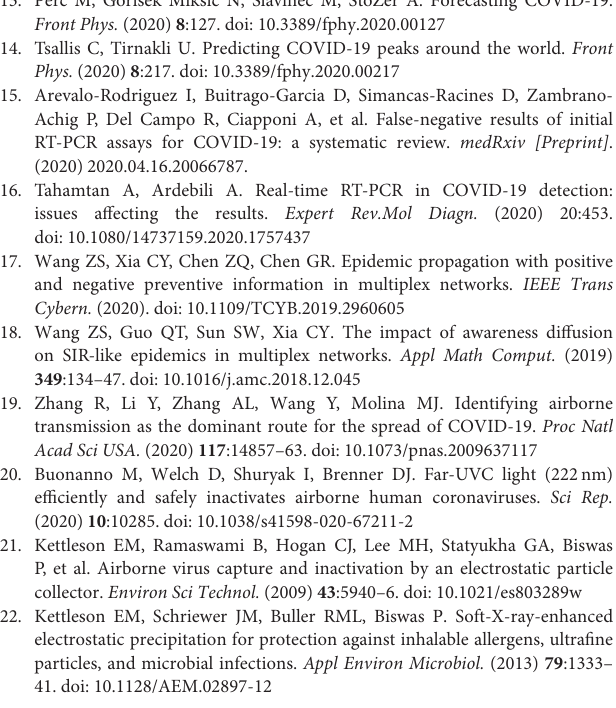
Figure 3E . The last five trials reproduce a scene as illustrated in Figure 3F . Green symbols indicate the moment of occurrence of new infections and orange circles represent the infected workers. The blue rectangles represent the infected workers in quarantine. We considered the same parameters mentioned in the Results section. Supplementary Video 2 | Video 2.MP4. Movie of the Python simulation for RSS = 75%. Note that the stochastic filtrating agent could be most efficient for RSS = 75% than for RSS =